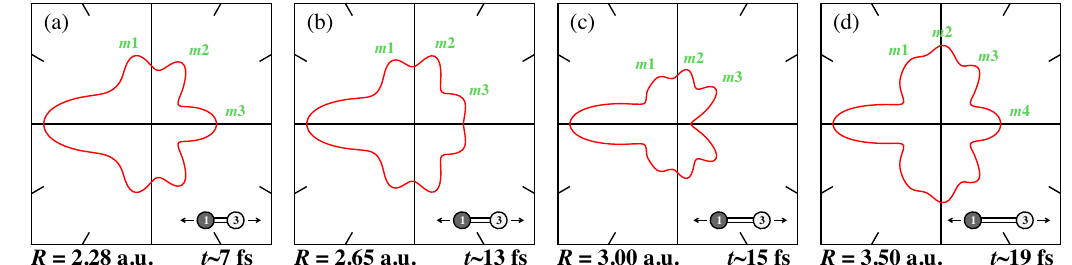
R = 2.28 a.u. FIG. 3. Polarization-averaged molecular-frame angular distributions of the second photoelectron emitted after the first Auger decay for different internuclear distances as obtained from our theoretical calculations. Distributions ranging from (a) R ¼ 2 . 28 a : u : (mean ground state internuclear distance) to (d) R ¼ 3 . 50 a : u : , which is the internuclear distance that can be reached within the duration of the XFEL pulse, are shown. The second photon has been absorbed by the ion on the right. An electron energy of 93 eV is used for the simulations. The labels m 1 to m 4 depict the different maxima mentioned in the text. The distributions are symmetric by definition with respect to the molecular axis.